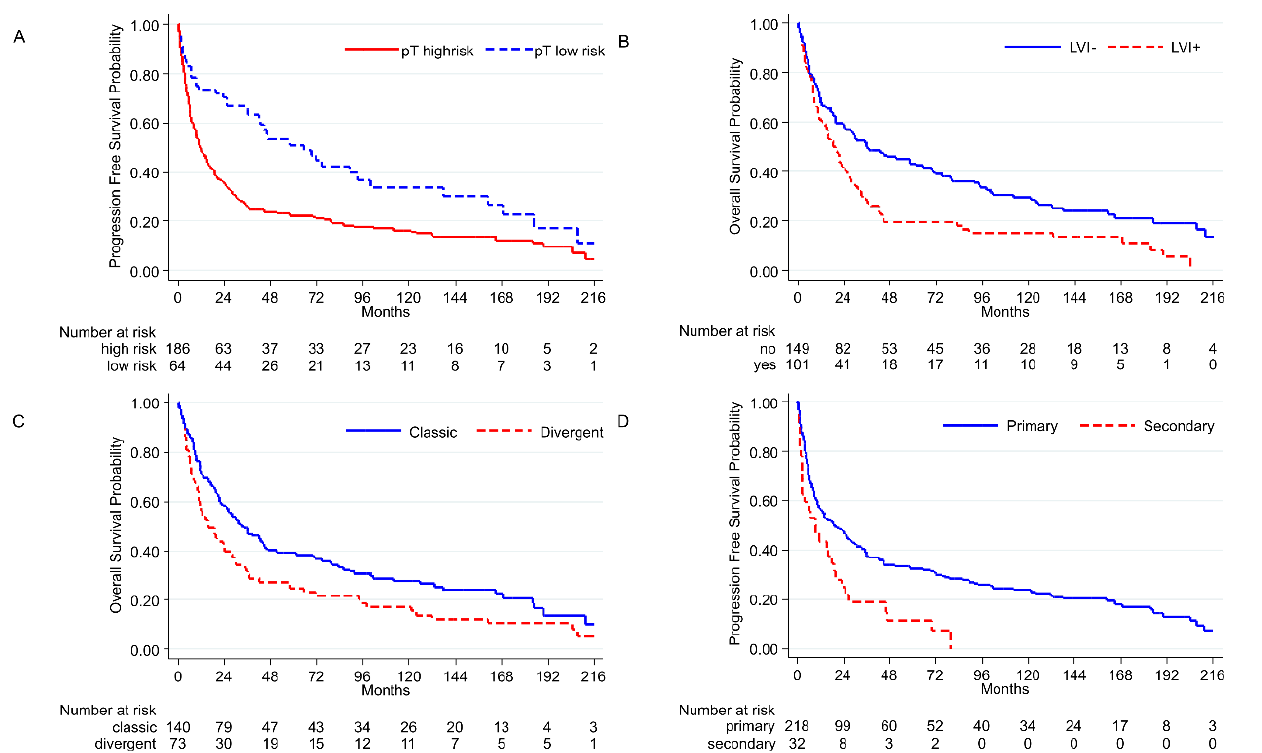
Figure 5. Most representative histopathological results: ( A ) High-risk stage (pT3-4 N0/N1) vs. low- risk stage (pT0-2 N0), PFS ( p < 0.0001); ( B ) lymphovascular invasion, OS ( p = 0.0006); ( C ) classic morphology vs. divergent morphology, OS ( p = 0.0127); ( D ) primary vs. secondary tumors, PFS ( p = 0.001).